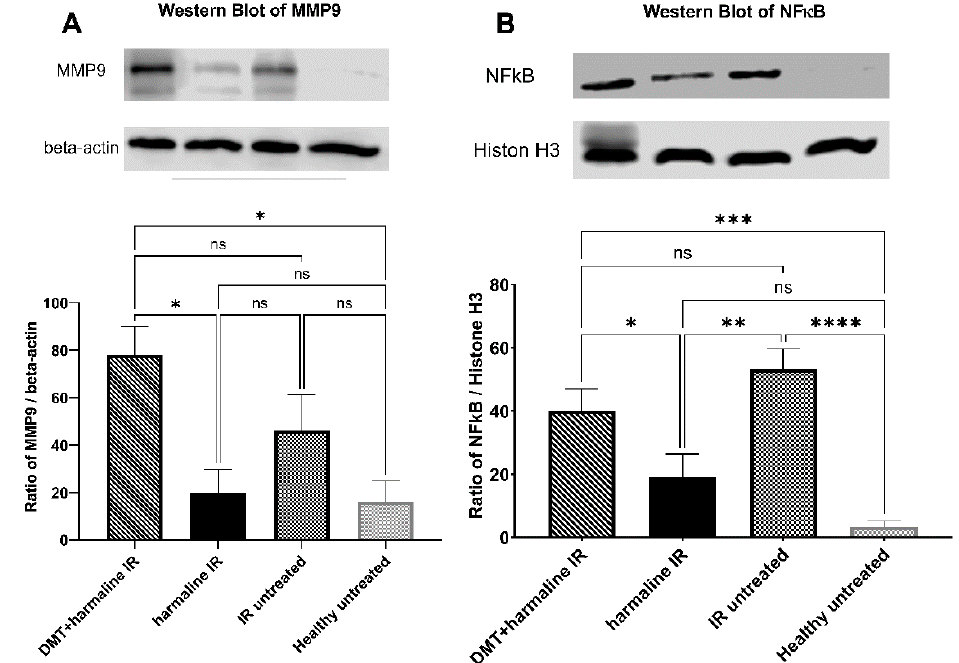
Figure 4. Western blot results. ( A ): Expression levels of Matrix metallopeptidase 9 (MMP9) in the different groups. ( B ): Expression levels of nuclear factor kappa-light-chain-enhancer of activated B cells (NF κ B) p65 subunit in the different groups. All results are plotted as mean percentages + SEM. ns = non-significant; * = p < 0.05; ** = p < 0.01; *** = p < 0.001; **** = p < 0.0001.